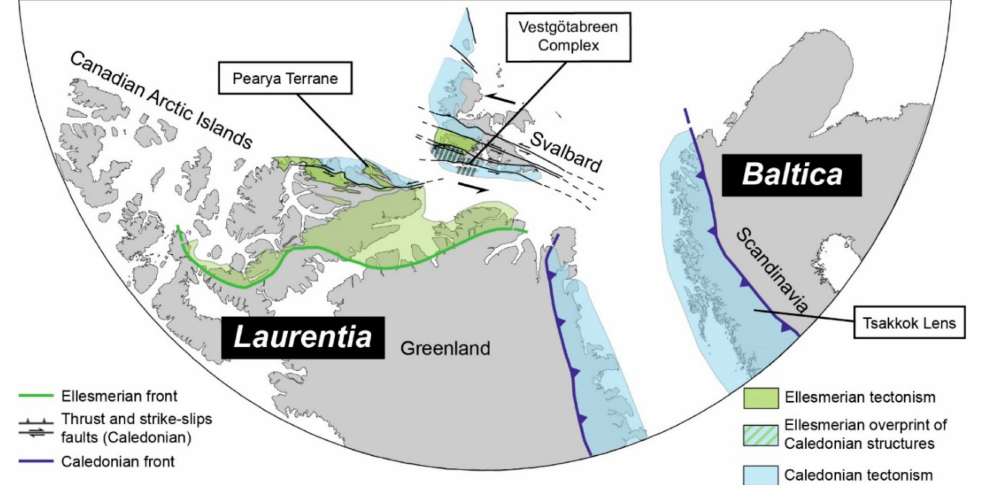
Figure 9. Schematic reconstruction of the positions of the Arctic islands of Canada and Greenland (i.e., Laurentia), Scandinavia(Baltica) andSvalbard inpost-Ellesmerian time. Theoverlays ofCaledonian and Ellesmerian tectonism are after Gee and Teben’kov [2] and Piepjohn et al. [17]. The deformation corresponding to Eurekan tectonism across the Arctic has been removed to highlight the distribution of Caledonian and Ellesmerian tectonism. A detailed illustration of all three tectonic events can be found in Piepjohn et al. [17]. The strike-slip faults through Svalbard and along the Pearya Terrane are Caledonian in age. Locations of the Vestgötabreen Complex in Svalbard, Tsäkkok Lens in the Scandinavian Caledonides and the Pearya Terrane in the Canadian Arctic are